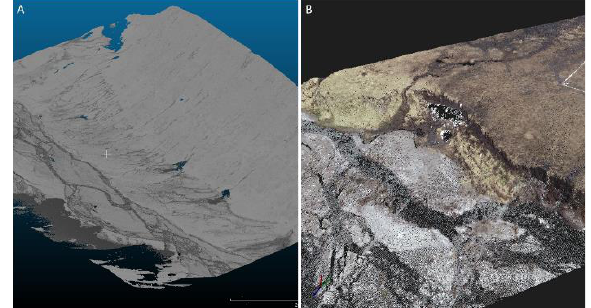
Figure 6. LiDAR DSM of the Rotmoos Valley (A); example of fine detail in the RGB textured LiDAR point cloud (B).